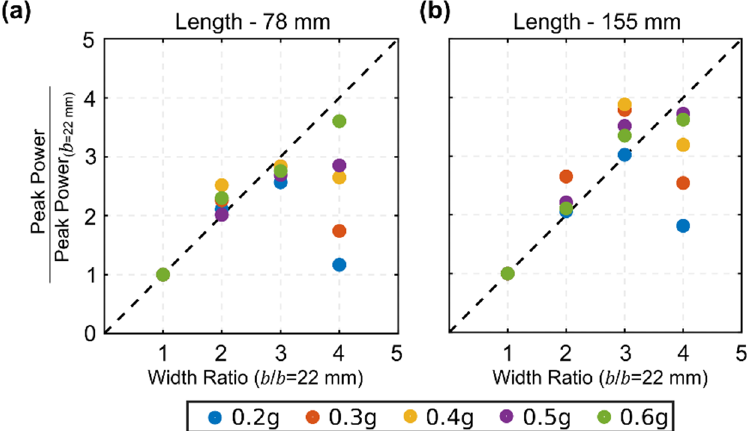
Figure 7. Peak power ratio of harvesters relative to that of the thinnest harvester with 22 mm width for different base excitation levels; ( a ) set of short harvesters (H1–H4); ( b ) set of long harvesters (H5–H8).